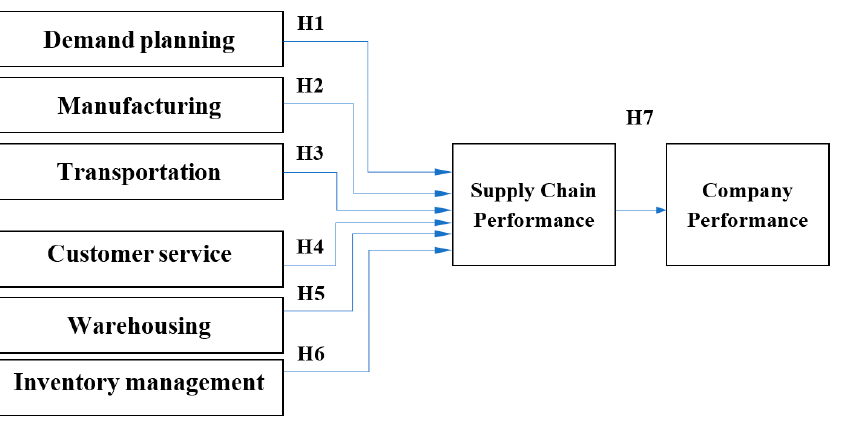
Figure 1. Proposed